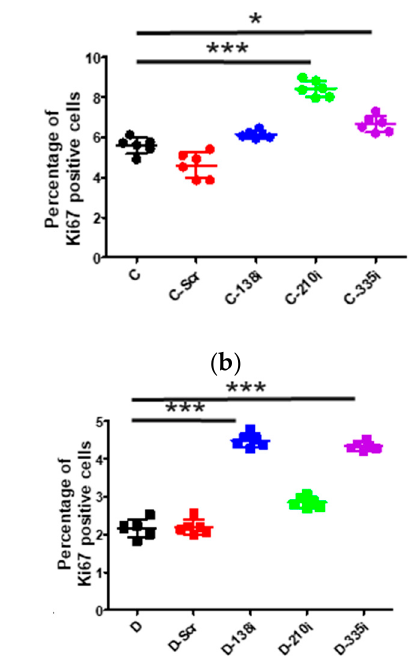
DAPI (blue); ×20 magnification, scale bar = 20 μ m. ( b – d ) Cell proliferation analysis with Ki67 immunofluorescence staining with anesthesia and miRNA inhibitor pretreatment relative to each control group at 24 h after exposure: ( b ) control anesthesia, ( c ) 3.6% sevoflurane anesthesia and ( d ) 10.4% desflurane anesthesia. Data showed as plots and mean ± SD (n sevoflurane, D: desflurane, Scr: scrambled miRNA, 138i: miR-138 inhibitor, 210i: miR-210 inhibitor and 335i: miR-335 inhibitor.